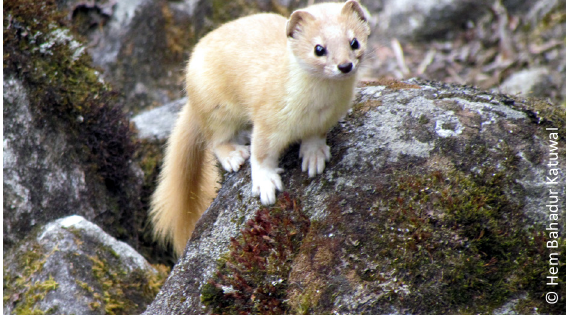
Image 7. Mountain Weasel Mustela altaica